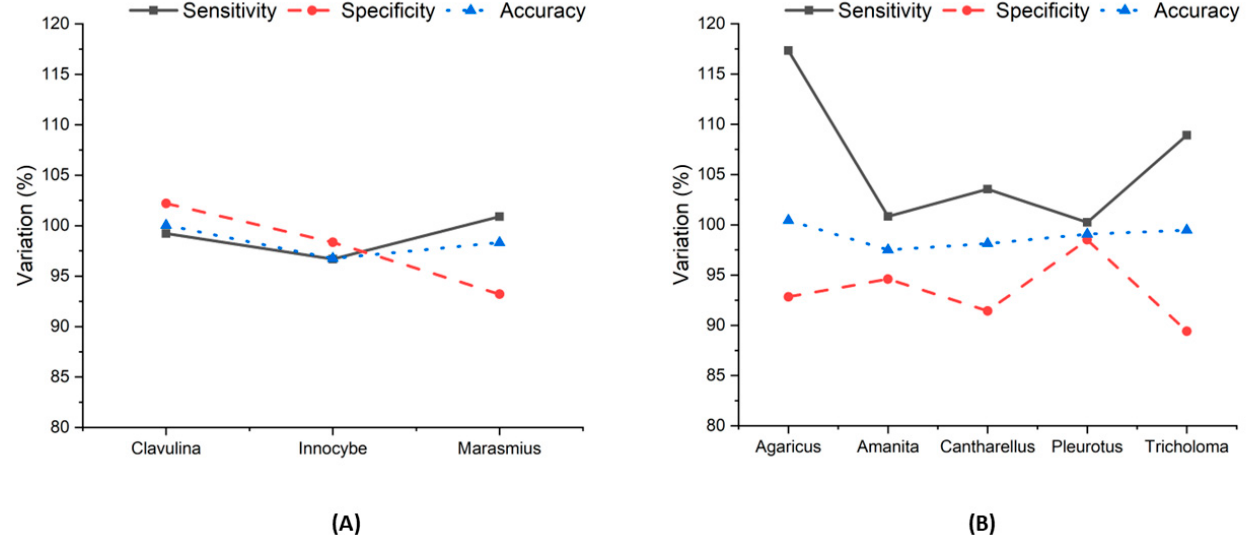
Figure 6. Comparison of statistical outputs when two different platforms are used: Smartphone vs. server-based classification. ( A ) For 3-class model ( B ) 5-class model.